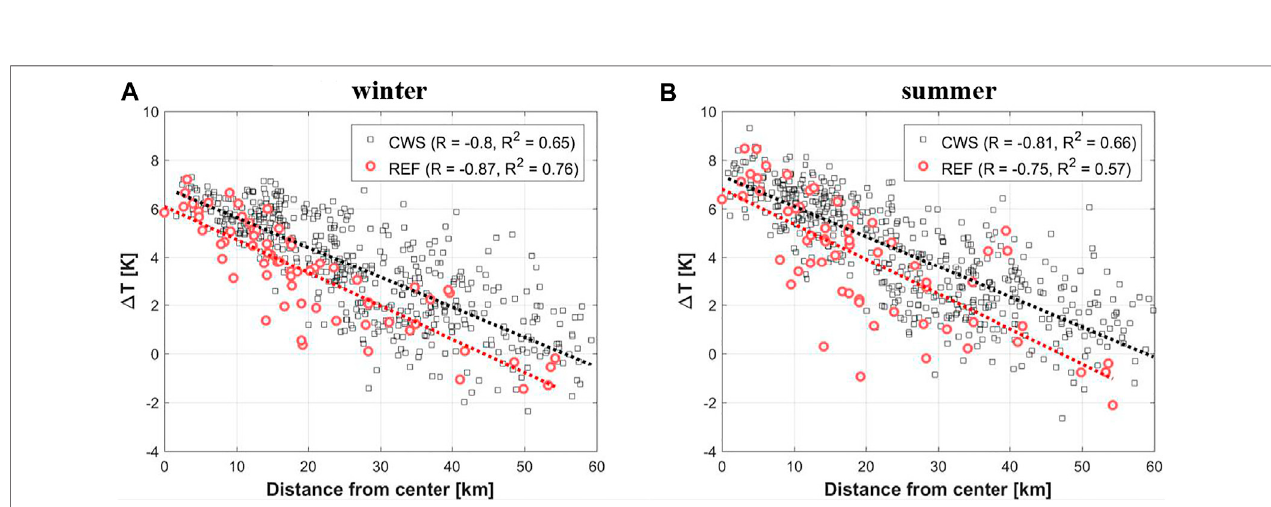
FIGURE5| DependencebetweenUHIintensity Δ T anddistancefromthecitycenter(BalchugWS)forwinter (A) andsummer (B) forreferencestationsandCWSs. Dotted lines indicate linear trends. R in the legend denotes Spearman correlation coef fi cient, R 2 denotes coef fi cient of determination.